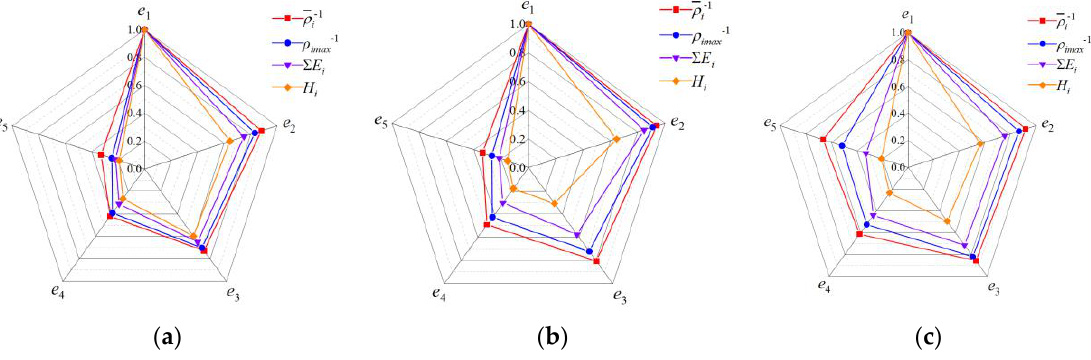
Figure 16. Wear depth and friction wear energy density of three blades of scheme 2 ( y i = 6.700 mm): ( a ) tooth 1; ( b ) tooth 2; ( c ) tooth 3.